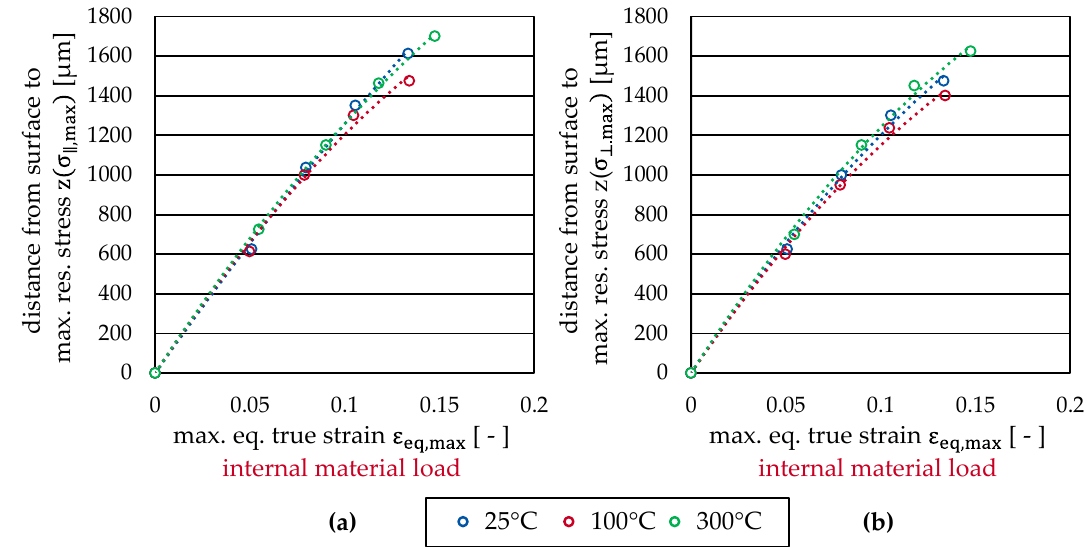
Figure 17. Simulated distances from the workpiece surface to the position where changes of the maximal residual stress components occur for different workpiece temperatures ( a ) for the maximum residual stress parallel to the rolling direction, and ( b ) for the maximum residual stress perpendicular to the rolling direction. All values derived from simulations.